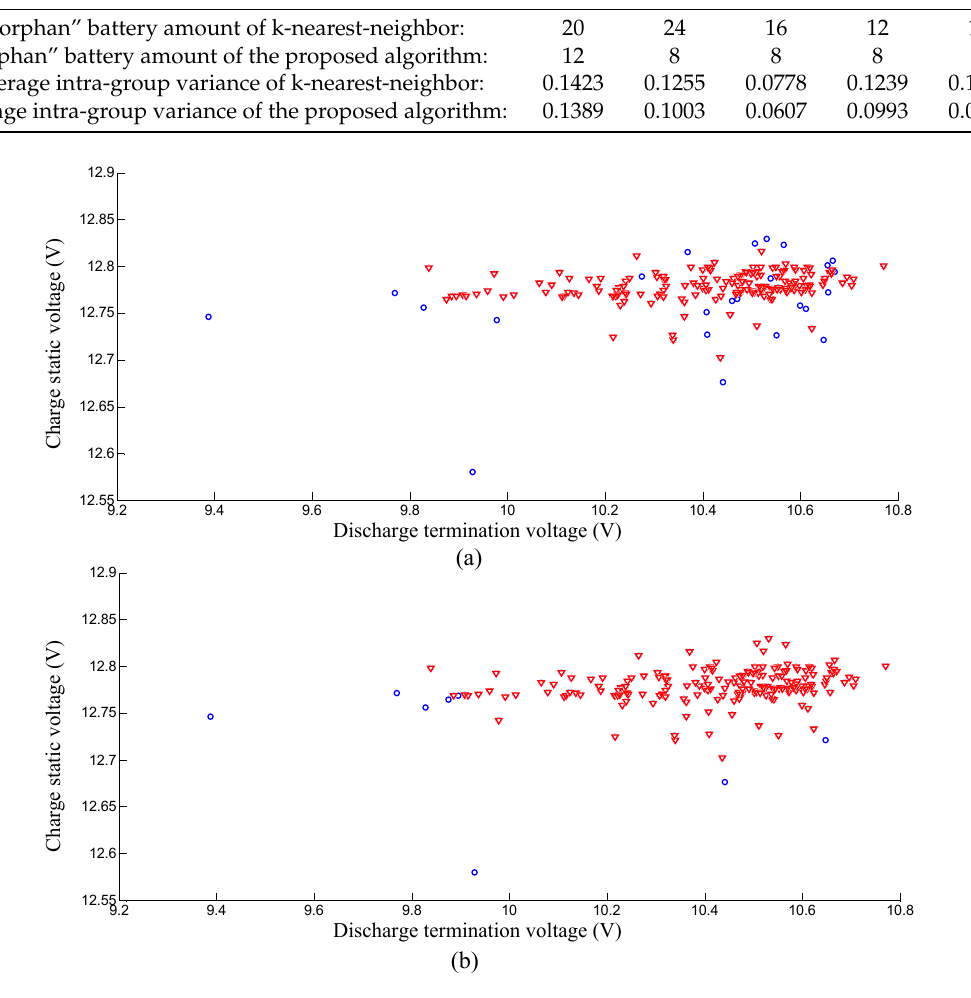
Figure 10. Comparison of failure amounts: ( a ) Results of original k-nearest-neighbor algorithm; ( b ) Results of the proposed method. Note that the red triangles represent the successfully-grouped batteries and the blue circles denote those grouping-failed (“orphan”)